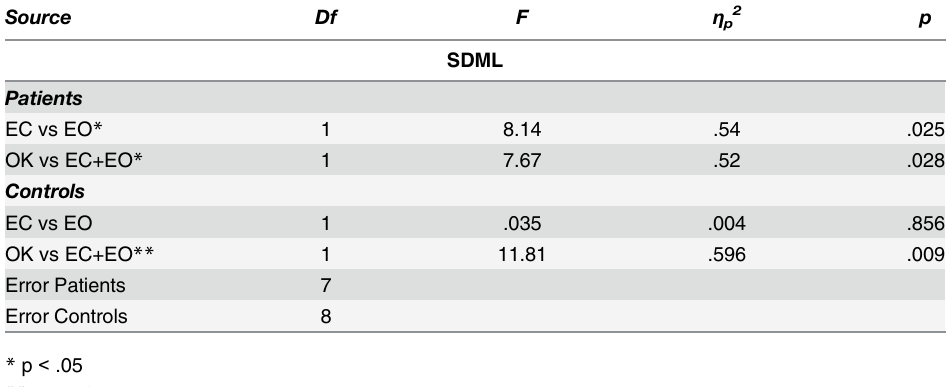
Table 3. Difference contrasts for the interaction between group and measurement type separated for each group for SDML.